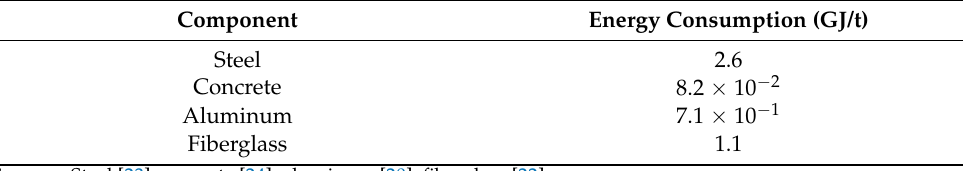
Table 5. Energy consumption factors on the recycling process of each material.